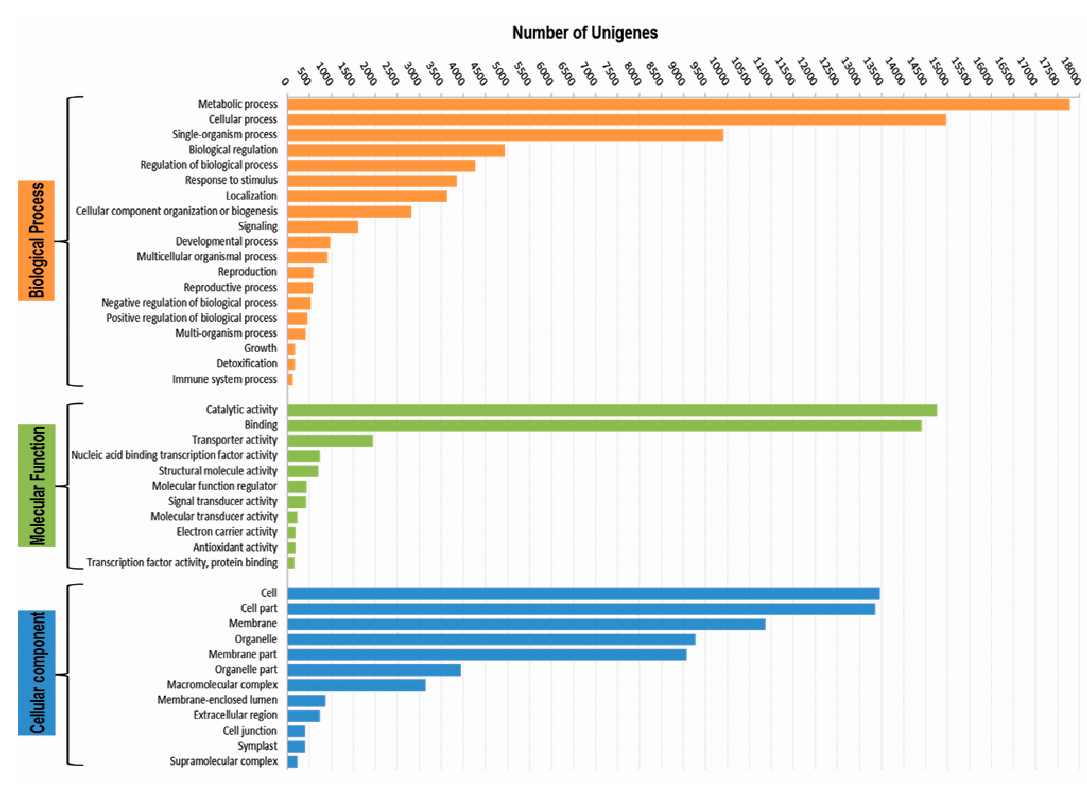
Figure 2. Functional classification of unigenes based on GO terms, showing GO category distribution of unigenes at GO level 2 into 3 categories: Biological Process, Molecular Function and Cellular Component.